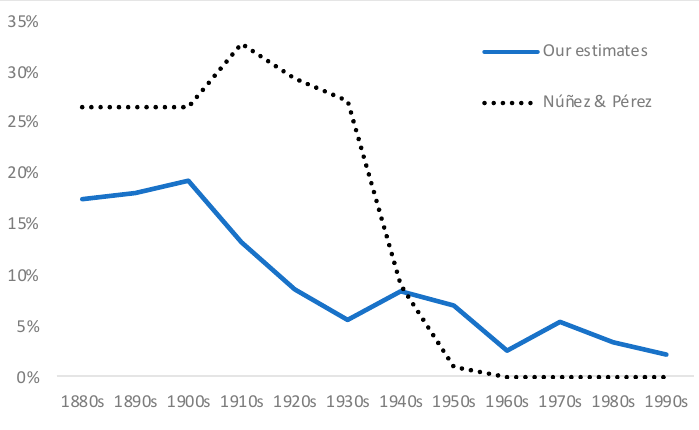
Figure 5. Evolution of moderate and severe stunting in Chile: Our data against Núñez and Perez’s estimates. Source: For Núñez and Pérez [24], for our estimates, Figure 2.